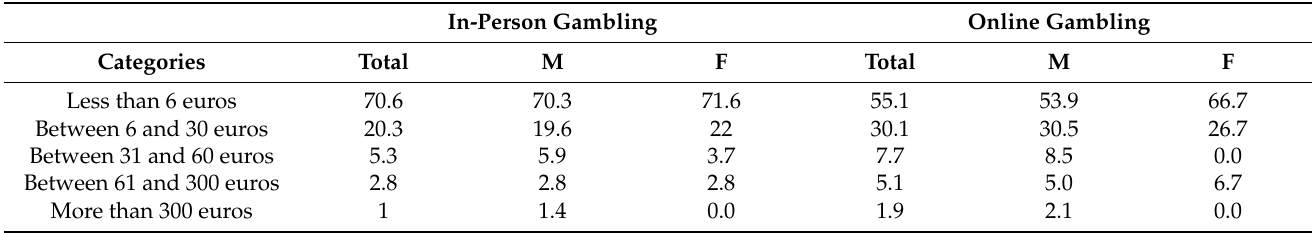
Table 4. Distribution of the maximum amount of money spent in one day according to gender and gambling modality (%) .